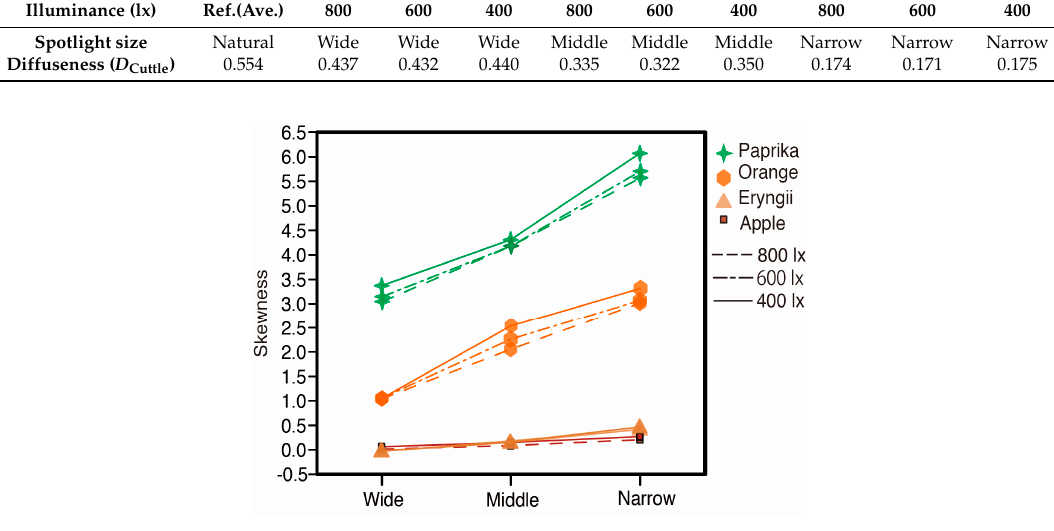
Figure 3. Relation between the skewness of the luminance histogram and spotlight size under three illuminance levels.